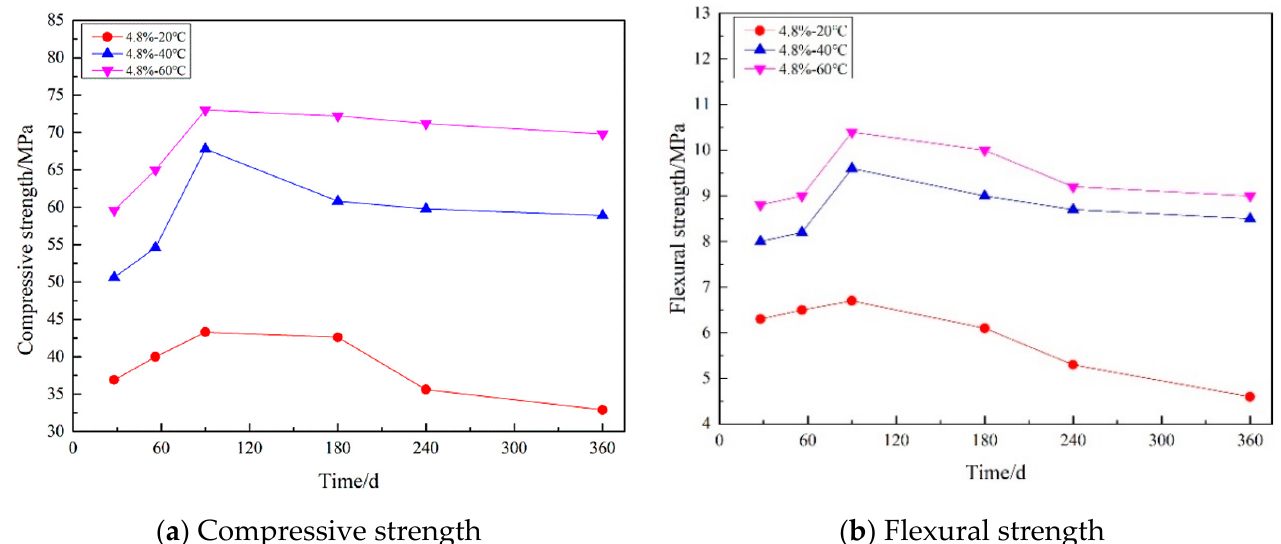
Figure 15. Strength of mortars added with 4.8% SO 3 at different curing temperatures.